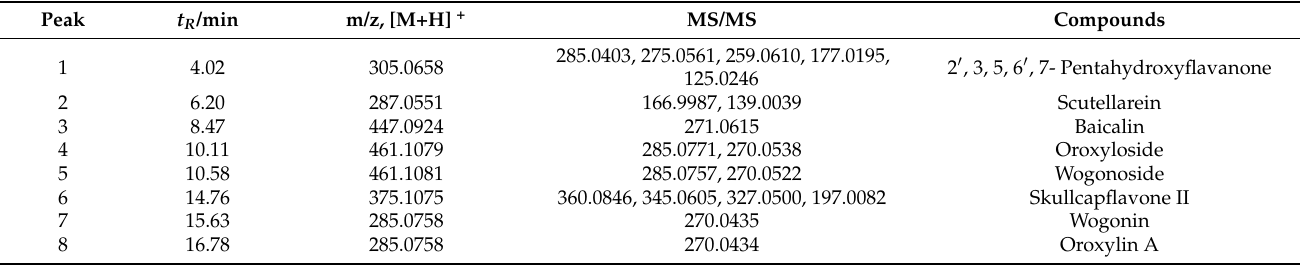
Table 1. MS/MS fragment ions of 8 compounds obtained by ligand